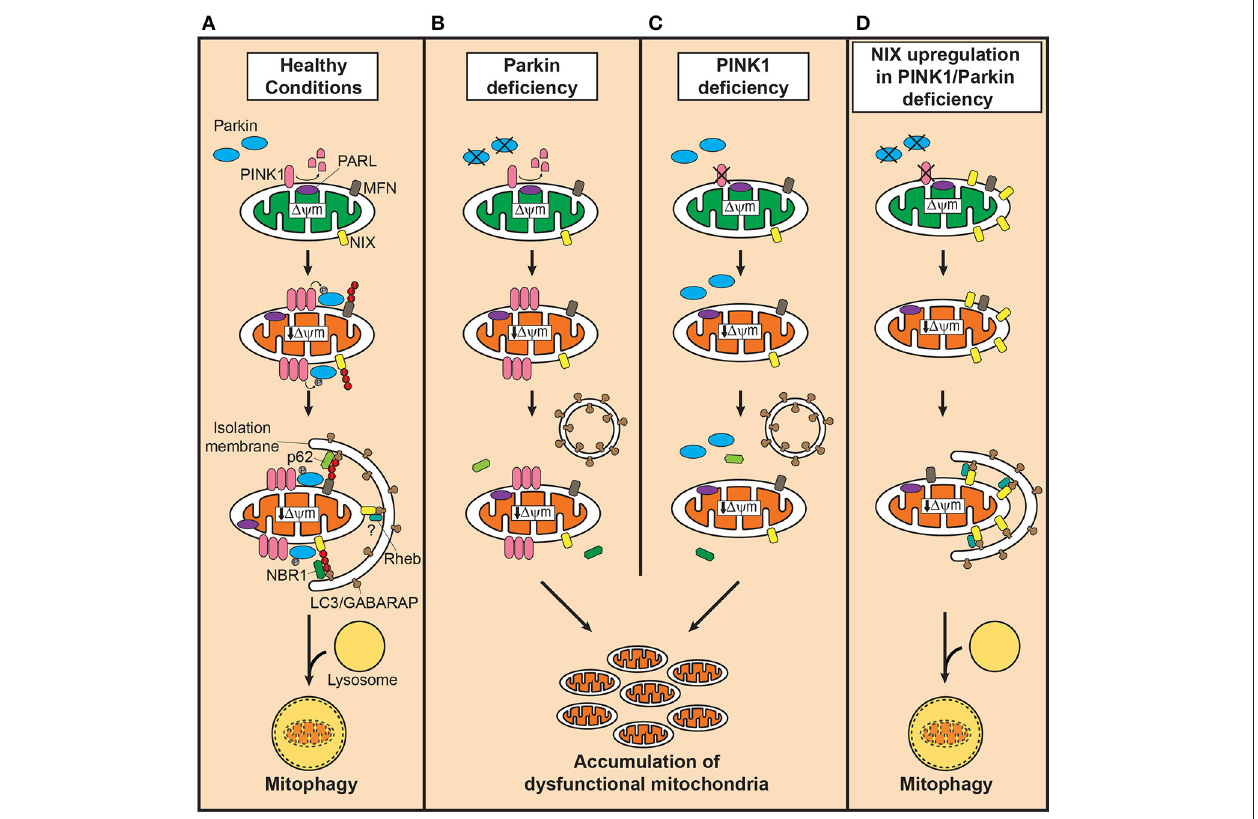
FIGURE 1 | Defective mitophagy in PINK1/Parkin-related Parkinson’s disease and the compensatory role of Nix in restoring mitophagy. (A) In healthy mitochondria, PINK1 is cleaved by presenilin-associated rhomboid-like protease (PARL). Dissipation of mitochondrial membrane potential decreases due to damage or aging, stabilizes PINK1 on the outer mitochondrial membrane (OMM) which in turn recruits Parkin to dysfunctional mitochondria. Parkin, activated by PINK1-mediated phosphorylation, ubiquitinates OMM such as mitofusins (MFN) to which the autophagosomal receptor microtubule-associated protein 1 light chain 3 (LC3)/gamma-aminobutyric acid receptor-associated protein (GABARAP) binds with polyubiquitine-binding proteins such as p62, optineurin and nuclear dot protein 52 kDa, leading to engulfment of dysfunctional mitochondria into autophagosomes. In the presence of Parkin, NIP3-like protein X (Nix) facilitates mitophagy by Parkin-mediated ubiquitination and recruitment of the polyubiquitine-binding protein neighbor of BRCA1 (NBR1). Although, Nix may mediate mitophagy independently of Parkin, its contribution is likely minor. Degradation of engulfed mitochondria occurs by fusion of autophagosomes with lysosomes. (B) In Parkin deficiency, accumulation of PINK1 occurs on the OMM of dysfunctional mitochondria, but the downstream events of polyubiquitination and subsequent recruitment of adaptor proteins fail to take place. (C) PINK1 deficiency, on the contrary, leads to failure in recognizing dysfunctional mitochondria, severely curtailing the efficiency of mitophagy. In both conditions, dysfunctional mitochondria accumulate due to impairment in inducing mitophagy. (D) Upregulation of Nix in PINK1 or Parkin deficiency, increases presence of Nix in dysfunctional mitochondria and mediates mitophagy by forming a complex with LC3/GABARAP and ras homolog enriched in brain protein (Rheb), maintaining mitochondrial quality control system and